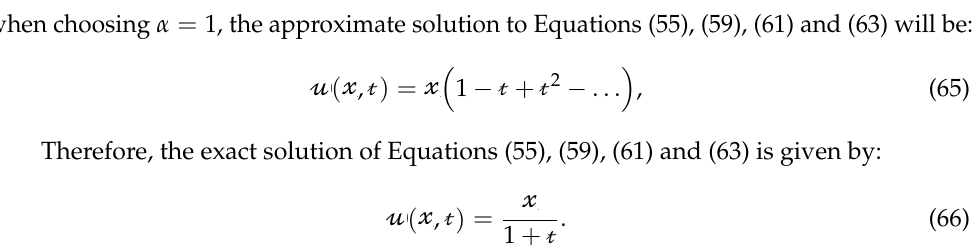
Figure 1. The graphs of the exact solutions among different values of 𝓉 , 𝛼 for the exact solution of Equation (45), exact solution of Equation (48), exact solution of Equation (50), exact solution of Equation (52) and the exact solution of Equations (45), (48), (50) and (52) at 𝛼 = 1 .